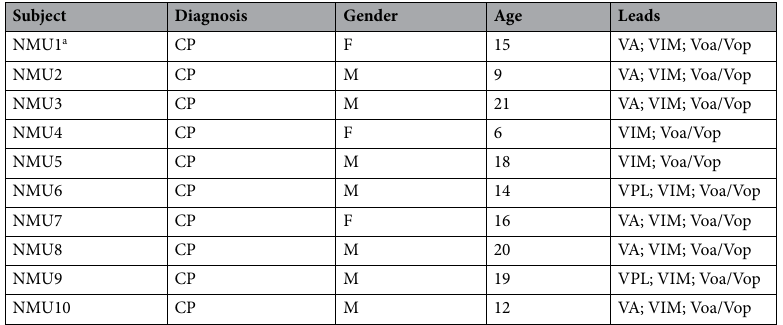
Table 1. Demographic characteristics. CP cerebral palsy, F female, M male, VPL ventral posterolateral nuclei, VA ventral anterior, VIM ventralis intermediate, Voa/Vop ventral oralis anterior/posterior 30 . a Subjects were identified from among the population of patients undergoing treatment in the neuromodulation monitoring unit (NMU) at Children’s Hospital of Los